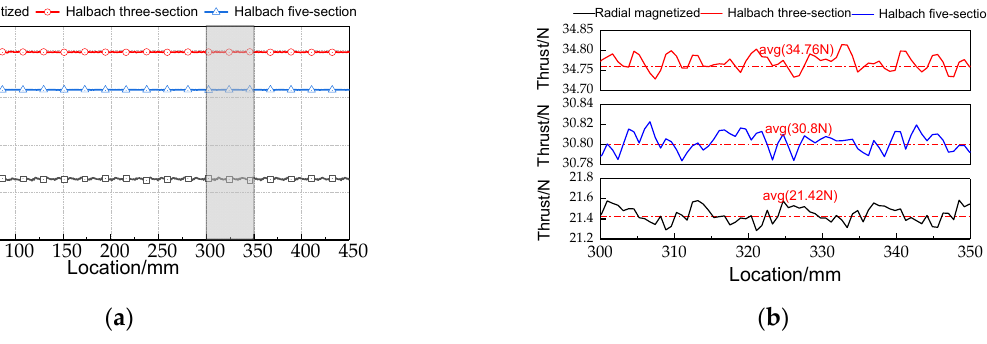
Figure 7. Electromagnetic thrust: ( a ) Bilateral combined electromagnetic thrust; ( b ) Regional thrust.